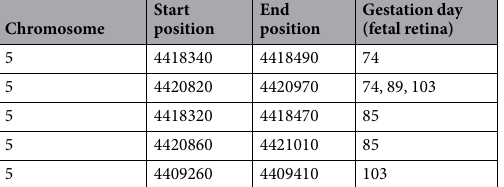
Table 3. DHSs active during fetal retina development at the 39 kb shared duplicated region (GRCh37/hg19 chr5:4396925–4436534). Gestation day 125 shows no active site at the 39 kb shared region. The fetal retina datasets were available from ENCODE 26 , produced by the Stamatoyannopoulos’